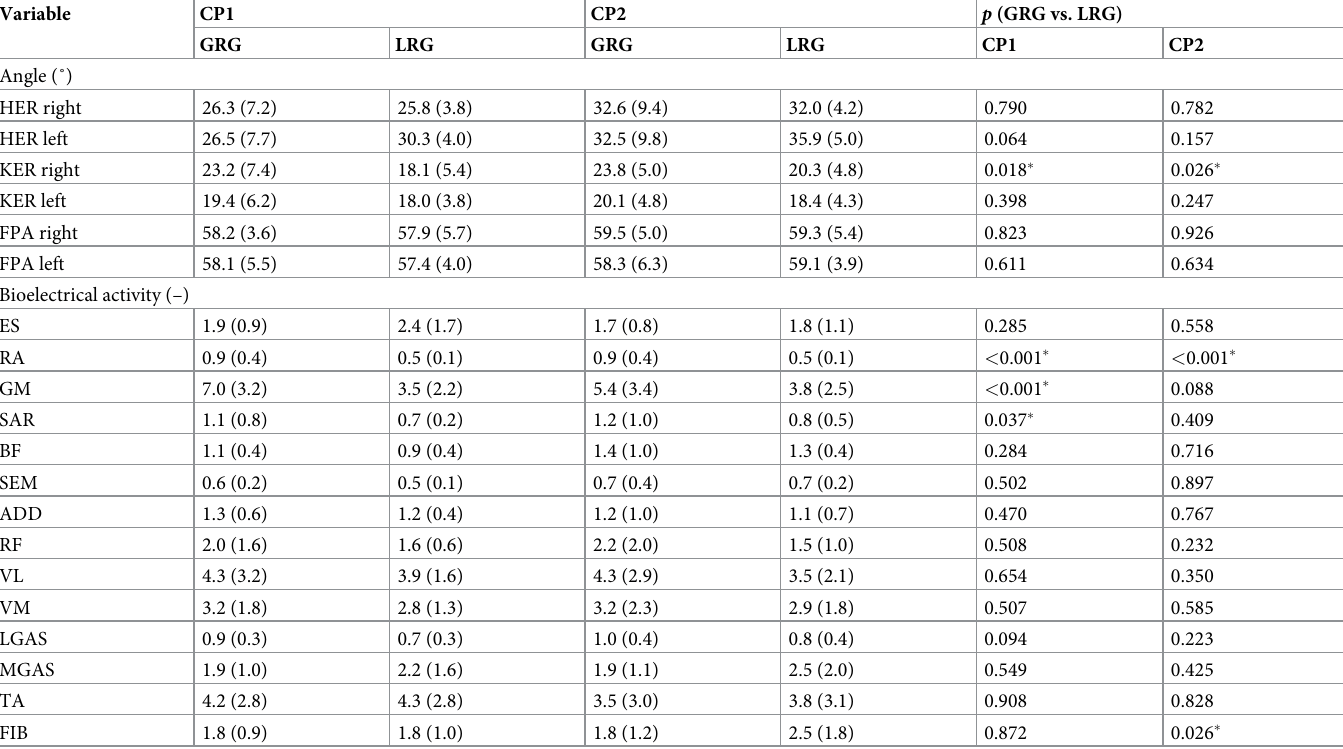
Table 2. Mean (SD) of the angles and bioelectrical activity in the first classical position (CP1) and the second classical position (CP2), and p -values.